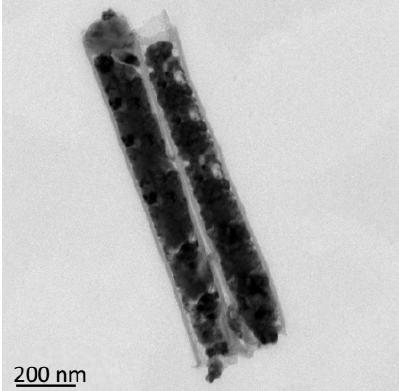
Figure 9. TEM image of the sample after 24 h in air.